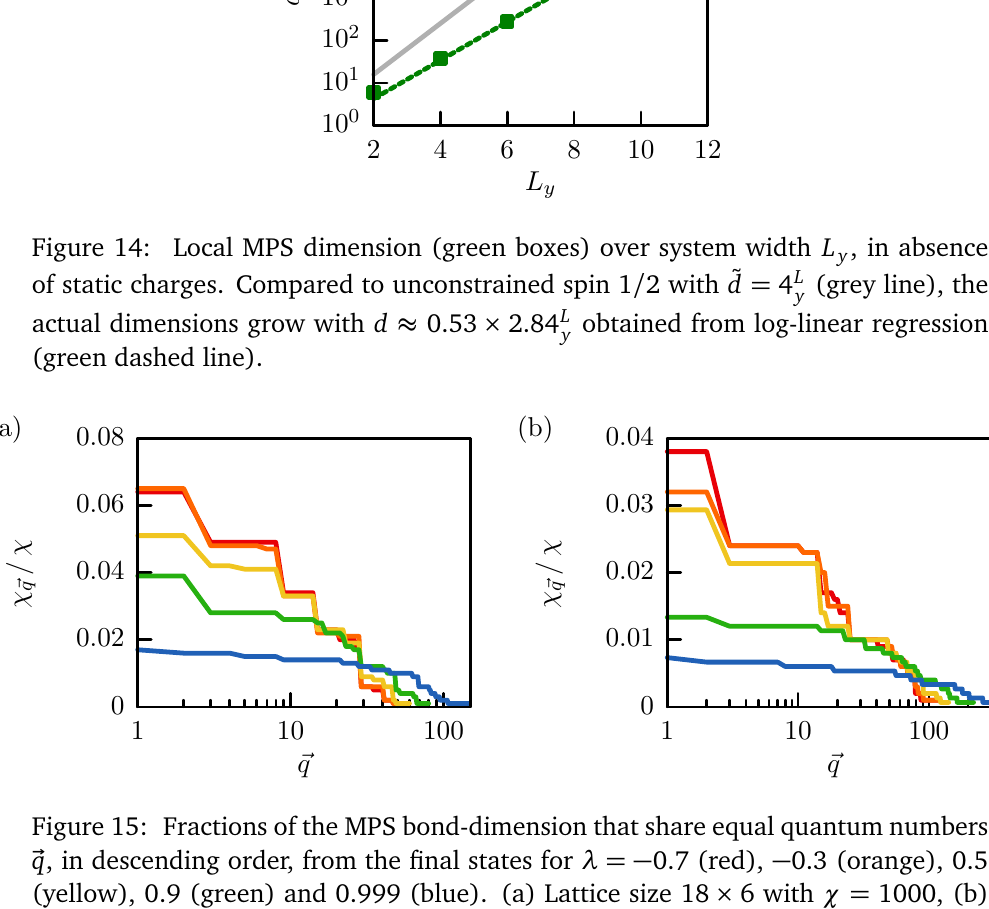
Figure 15: Fractions of the MPS bond-dimension that share equal quantum numbers (cid:126) q , in descending order, from the final states for λ = − 0.7 (red), − 0.3 (orange), 0.5 (yellow), 0.9 (green) and 0.999 (blue). (a) Lattice size 18 × 6 with χ = 1000, (b) 24 × 8 and χ =